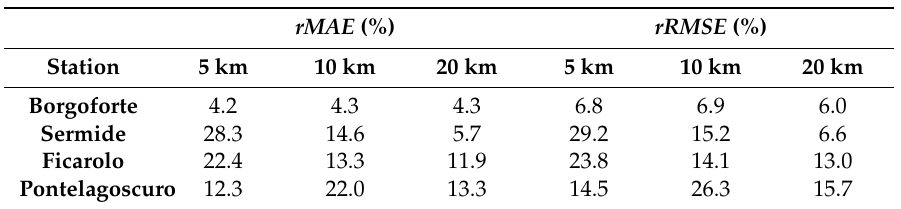
Table 4. Mean rMAE (%) and rRMSE (%) obtained from the comparison of simulated and remotely-sensed FDCs at the gauging